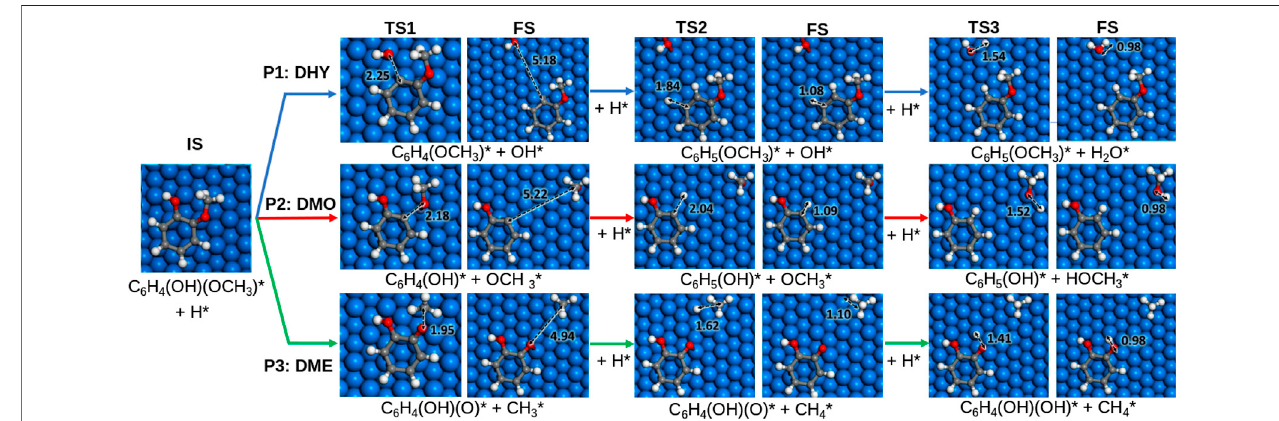
FIGURE 2 | Proposed reaction pathways for the hydrodeoxygenation of guaiacol on Ni (111). Colour scheme: Oxygen, red; hydrogen, white; carbon, grey and nickel, blue. The asterisk (*) denotes adsorbed surface species. Functional groups are indicated in parenthesis.